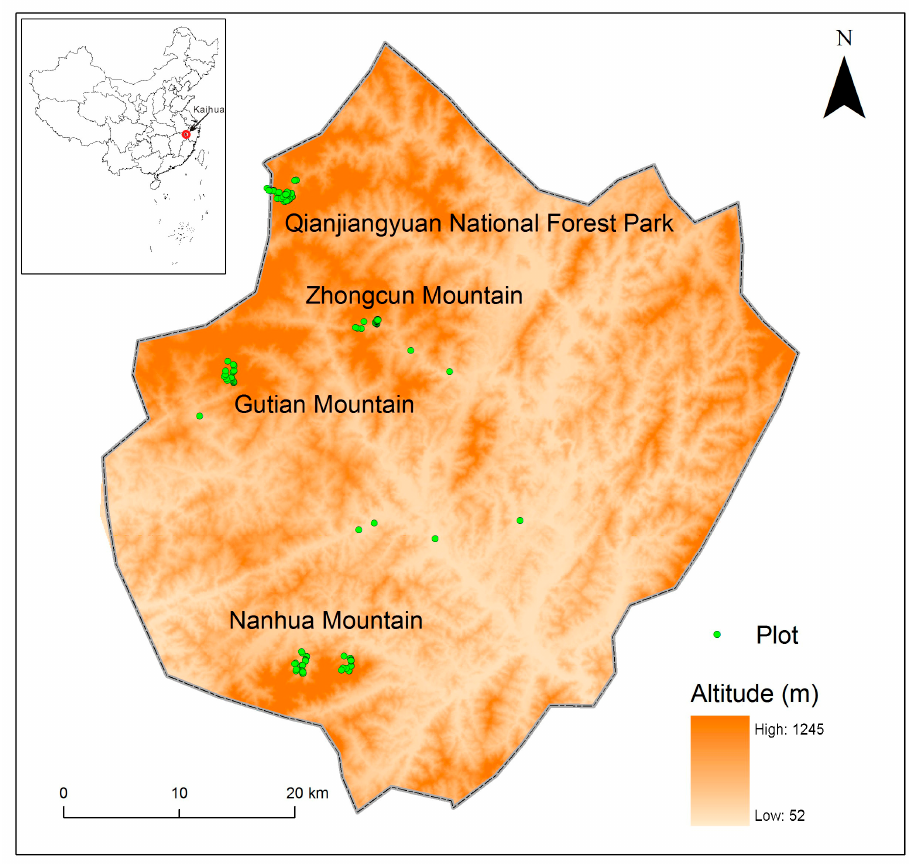
Figure 1. Location of the study area and the distribution of the surveyed plots.